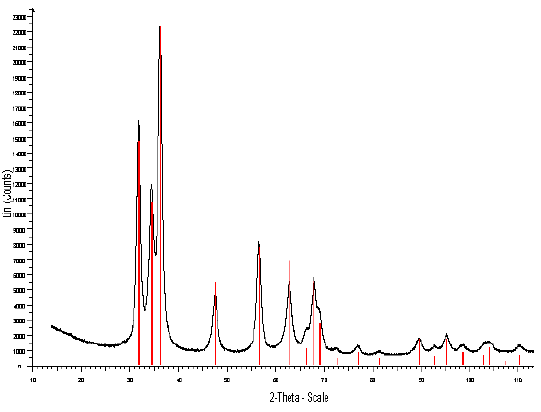
Figure 3. Rietvield refinement of sample 2. Table 2. Quantitative analysis made by LA-ICP-MS method for the sample with nominal composition 5TiO2.95ZnO (sample 2). Sample Oxides